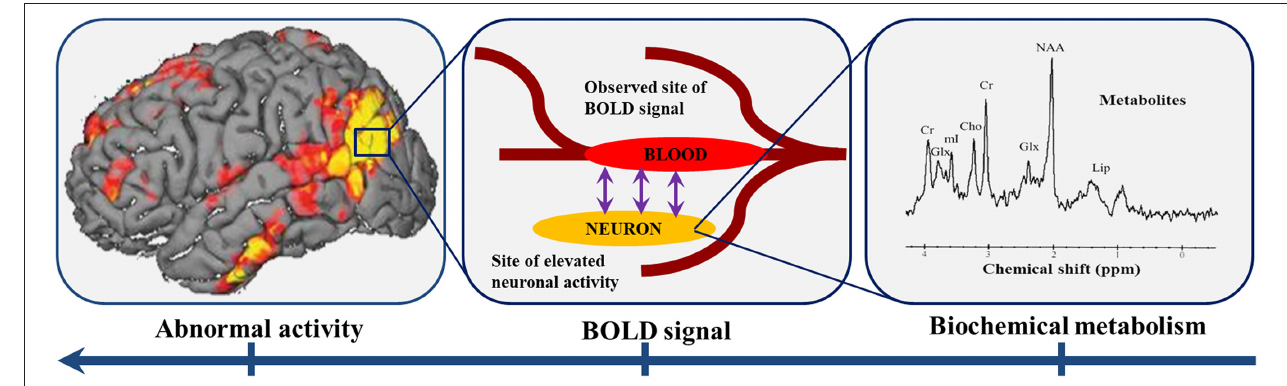
FIGURE 1 | Neurotransmitter-mediated signal transmission plays an important role in regulating cerebral blood flow. The abnormal BOLD signal in the brain region reflects the abnormal activity of neurons in the corresponding region, which may be accompanied by changes in the biochemical metabolism of the brain. BOLD: blood oxygen saturation level